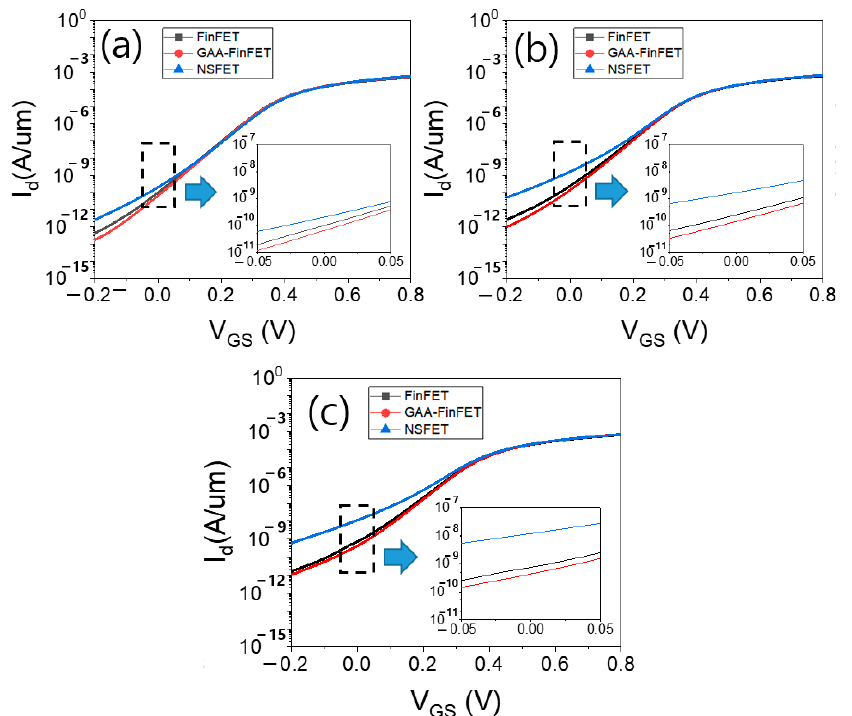
Figure 12. The input transfer characteristics of the three devices (V DS = 0.7 V) for proximities of ( a ) 8 nm, ( b ) 5 nm, and ( c ) 3 nm. Please note that the doping concentration in the sub-channel region is set to 5 × 10 17 cm − 3 .